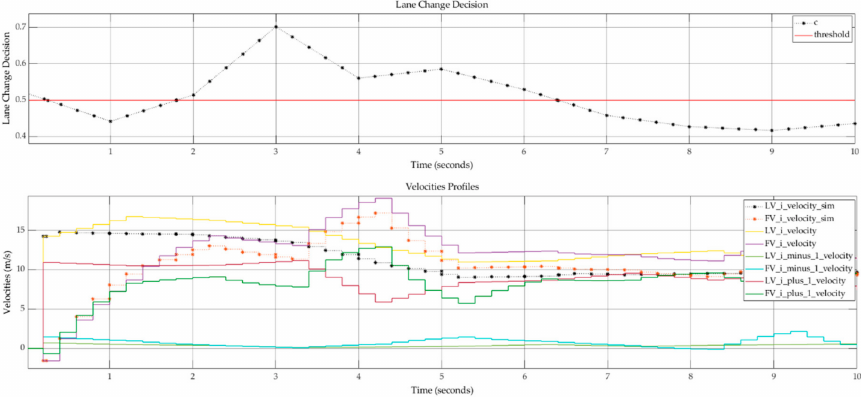
Figure 11. LV and FV–velocities